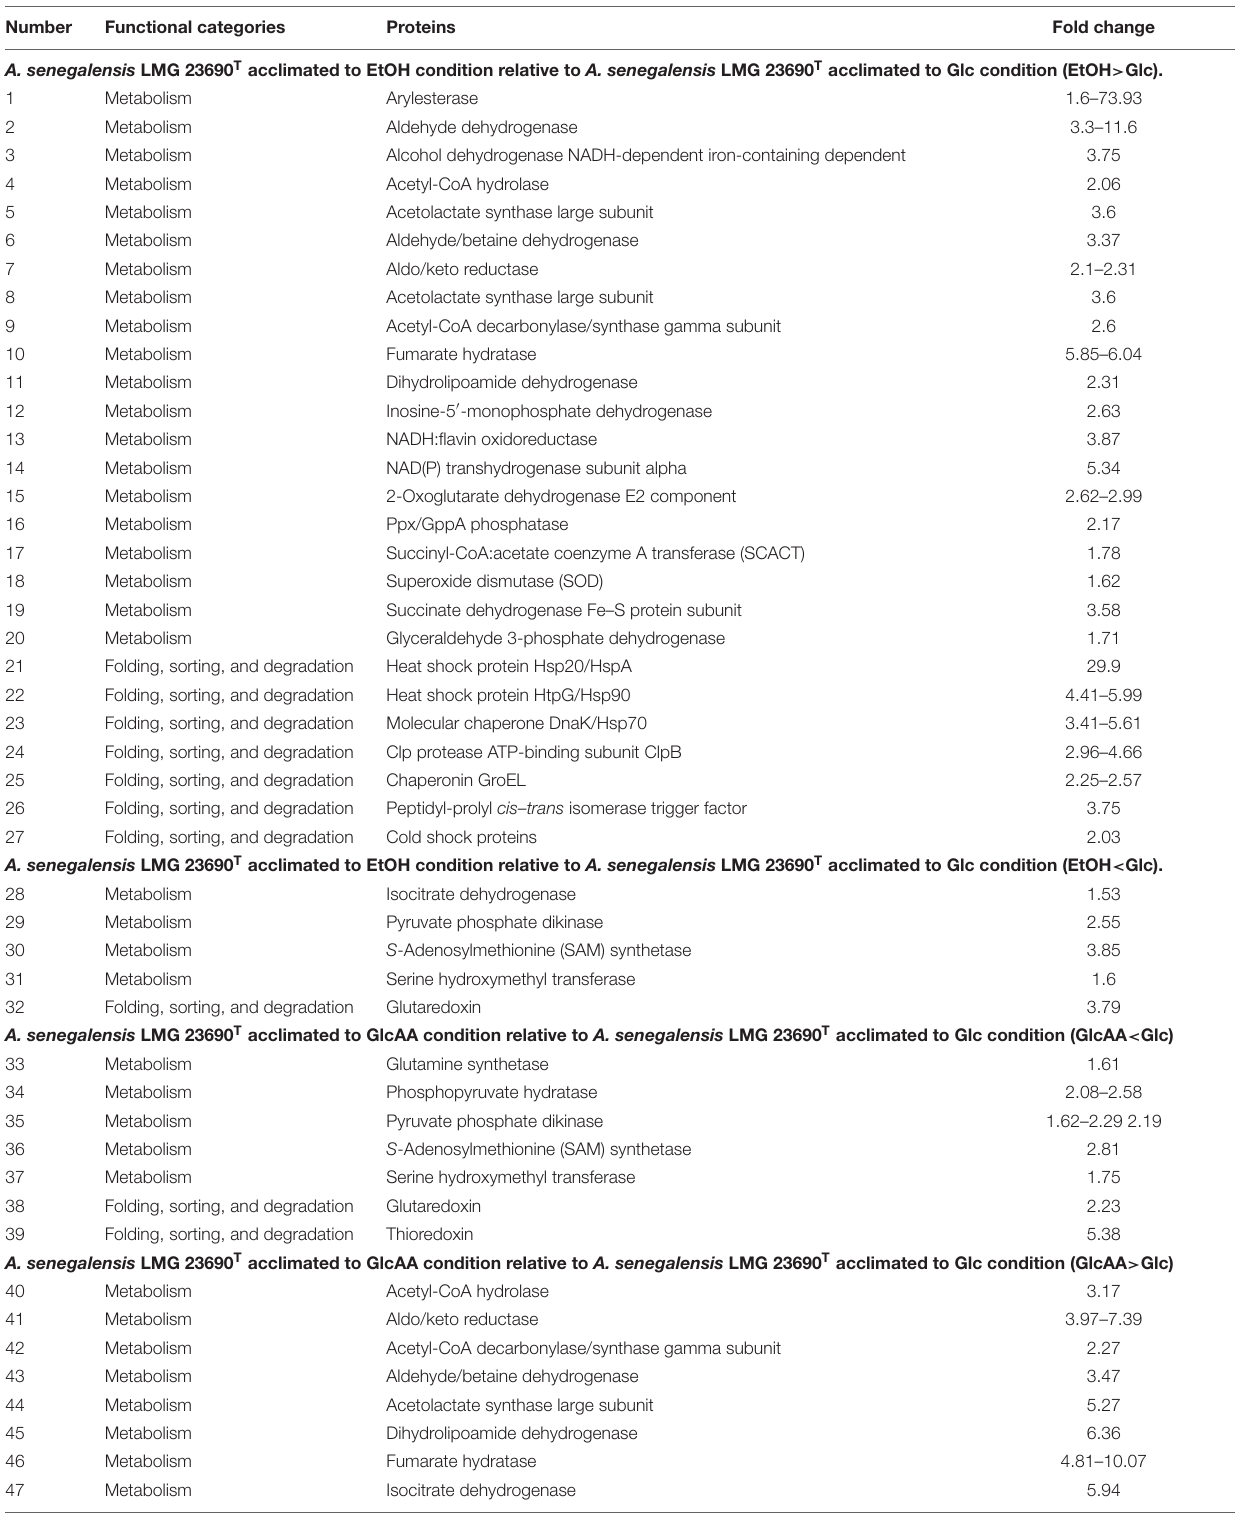
TABLE 2 | Functional categories and fold change of differentially regulated proteins identified in Acetobacter senegalensis LMG 23690 T acclimated to different carbon